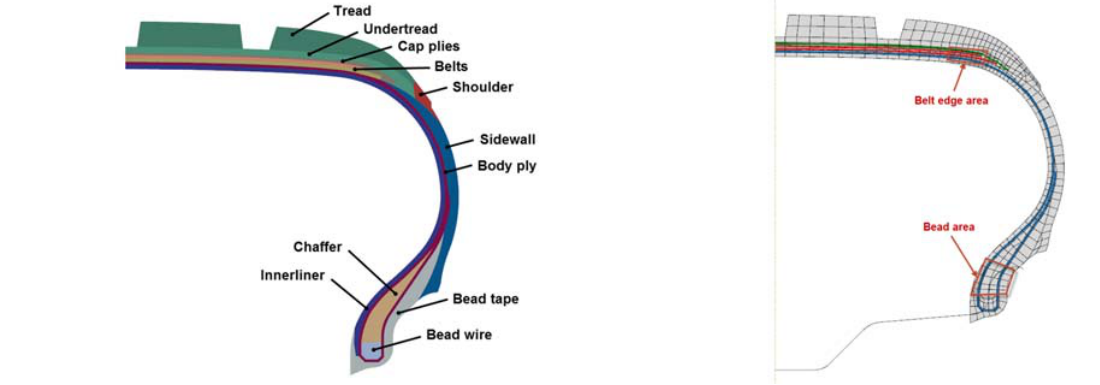
Fig. 1. Components of a radial tire Fig. 2. Axisymmetric finite element tire model